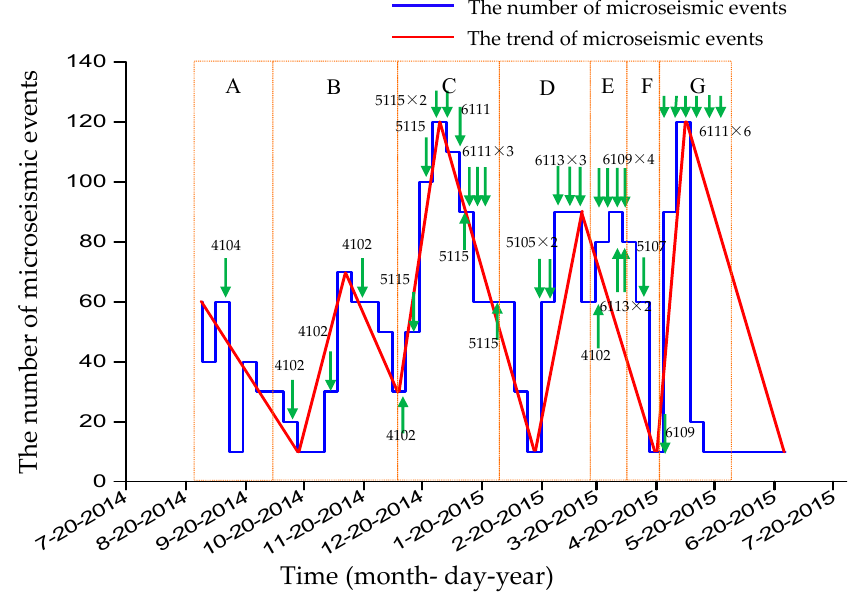
Figure 8. The variation of microseismic events of different time: A–G represents the different time intervals.